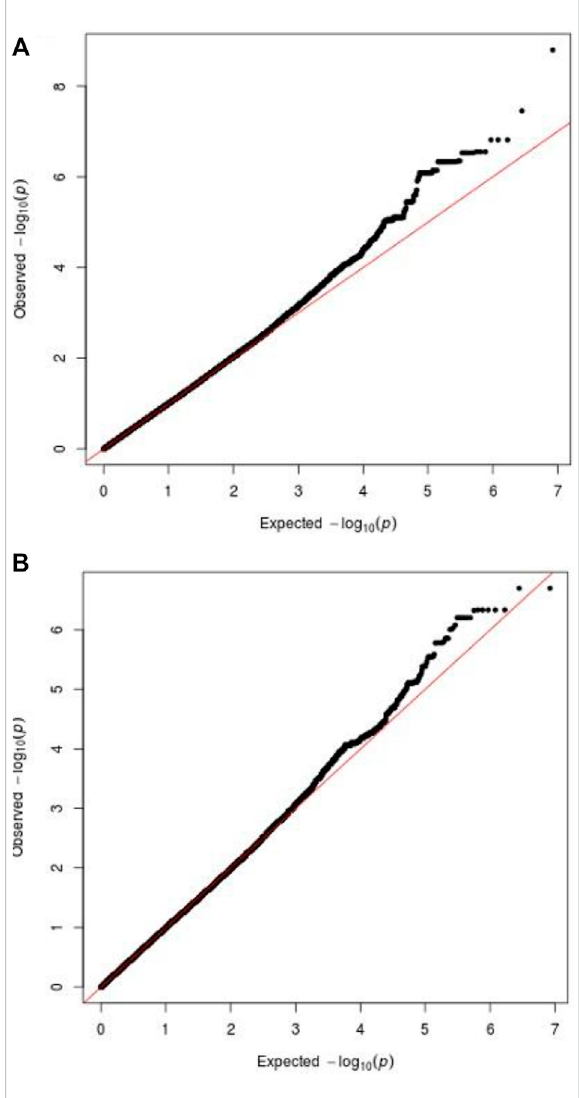
FIGURE 5 Q-Q plot for phenotypes. The above two fi gures show ‘ Q-Q plot for SSWM ’ (A) , ‘ Q-Q plot for DSWM ’ (B)